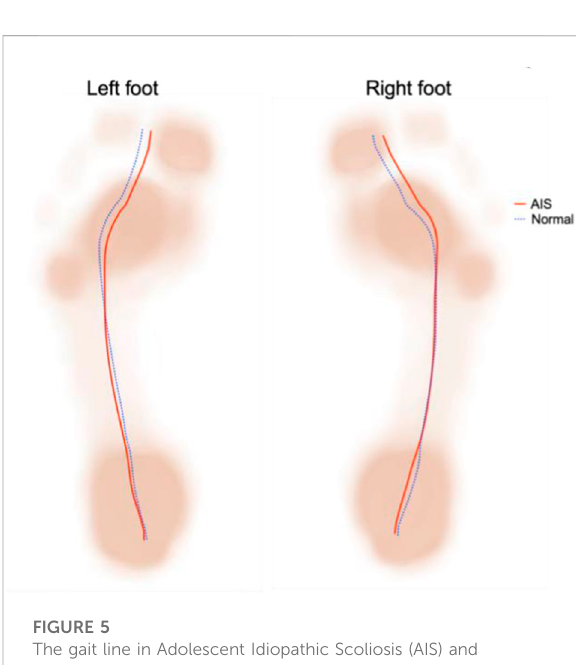
FIGURE 5 The gait line in Adolescent Idiopathic Scoliosis (AIS) and normal groups.Obviously ,the two groups are different, and bipedal asymmetry and Inconsistent change